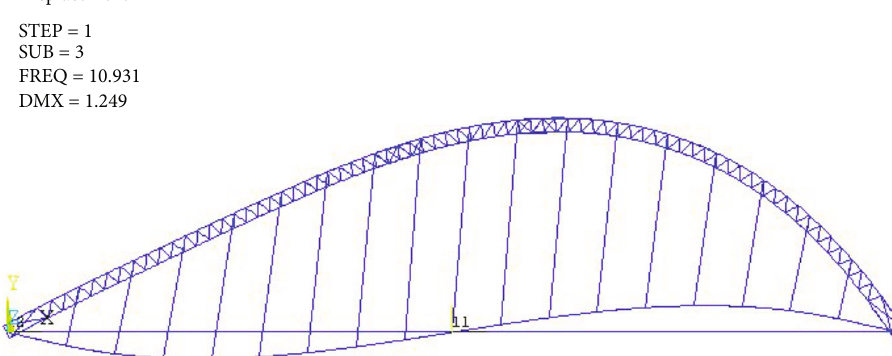
Figure 18: The third order buckling mode of arch bridge under case 1.